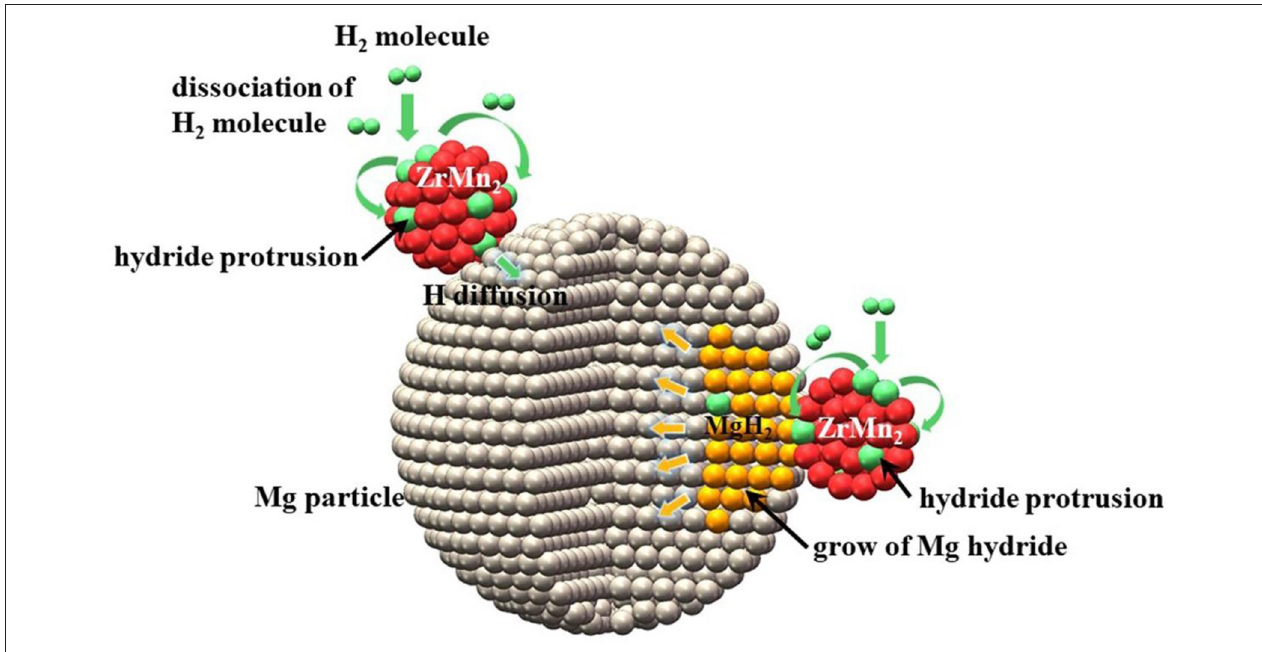
FIGURE 3 | Schematic summary of hydrogenation mechanism of Mg particle catalyzed by ZrMn 2 nanoportals. Reproduced from Zhang et al. (2019a) with permission from Royal Society of